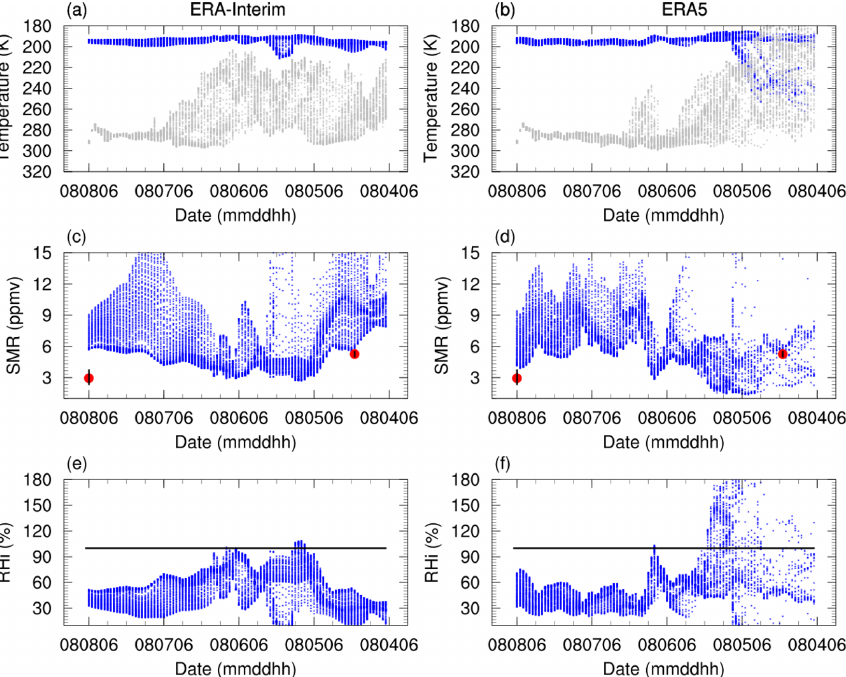
Figure 8. The time evolution of (a, b) the temperature (blue dots) and brightness temperature from FY-2D (grey dots), (c, d) the saturation water vapour mixing ratio (SMR), and (e, f) relative humidity over ice (RH i ) along 4d backward trajectories of air parcels on 376–384K from (a, c, e) ERA-Interim and (b, d, f) ERA5 diabatic trajectories. The red dots in c and d denote the water vapour mixing ratio from MLS (left-hand side) and balloon observation (right-hand side).